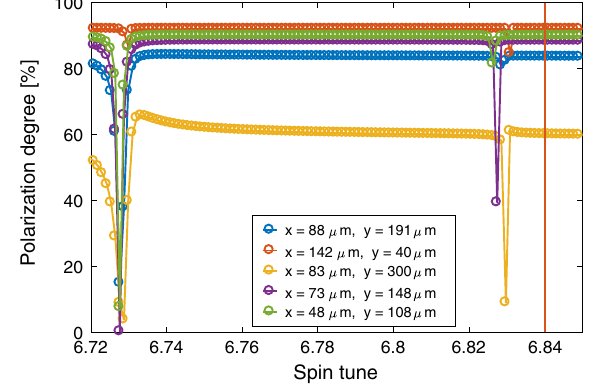
FIG. 2. The beam polarization level calculated by SLIM for various sets of closed orbit distortions which were generated randomly by the orbit disturbances. The rms values of the horizontal and vertical orbit distortions are shown in the legend. The red vertical line shows the experimental operational spin